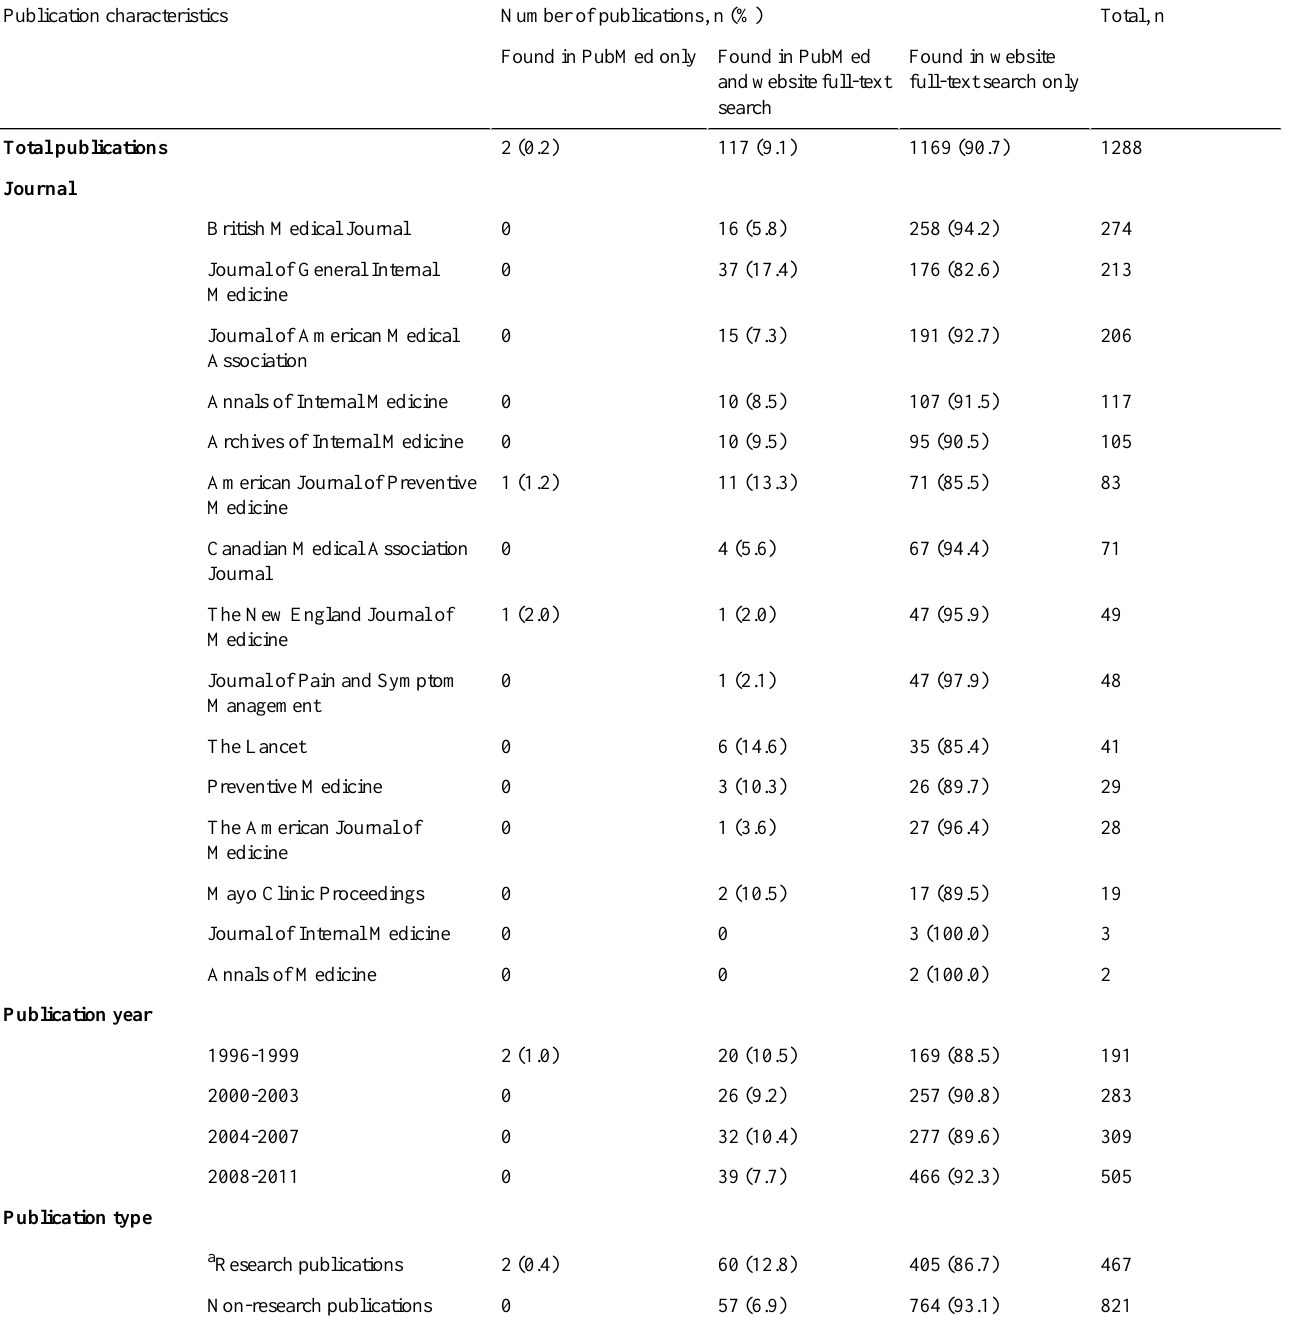
Table 1. Characteristics of publications containing the shared decision making phrase according to the specific search method (N=1288).